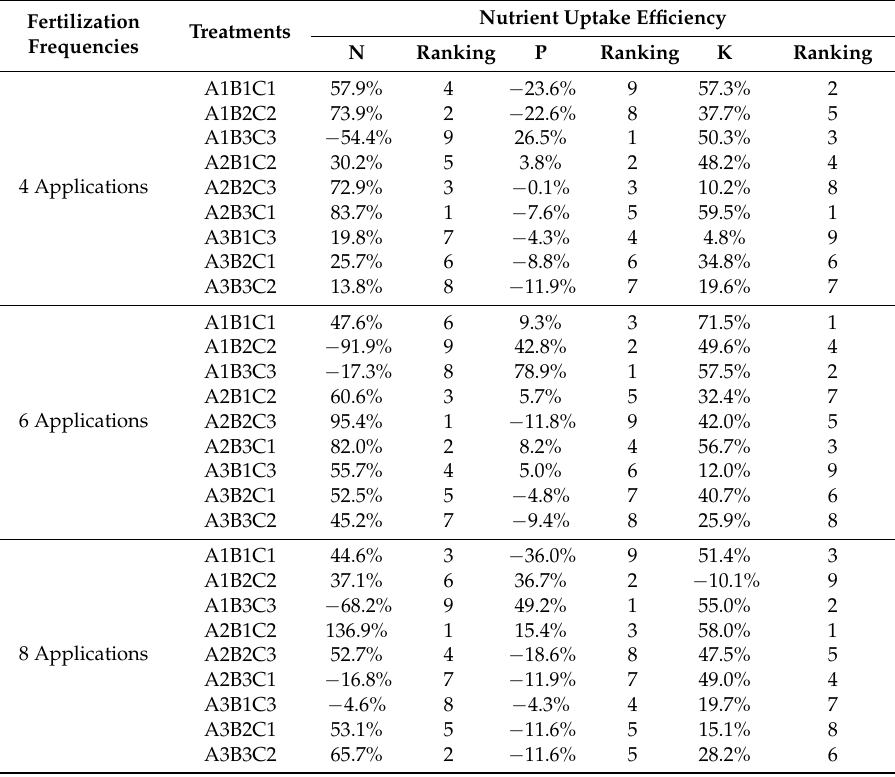
Table 12. Effects of different fertilization ratios and frequencies on nutrient uptake efficiency. Fertilization Frequencies